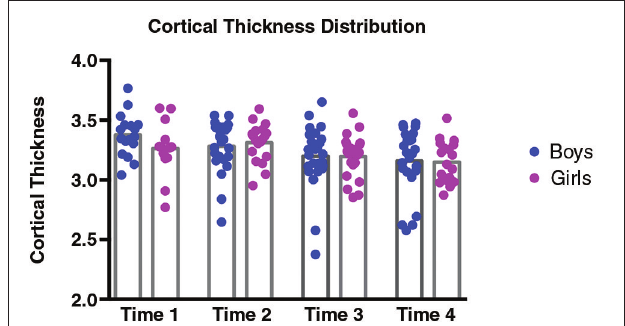
FIGURE 4 | Distributions of cortical thickness for girls (pink) and boys (blue) separately at each Time point . At Time 1, average cortical thickness was 3.26 for girls, and 3.38 for boys; at Time 2, average cortical thickness was 3.31 for girls, and 3.28 for boys; at Time 3, average cortical thickness was 3.2 for girls, and 3.2 for boys; and finally at Time 4, average cortical thickness was 3.15 for girls, and 3.16 for boys. None of the differences in CT values between girls and boys were